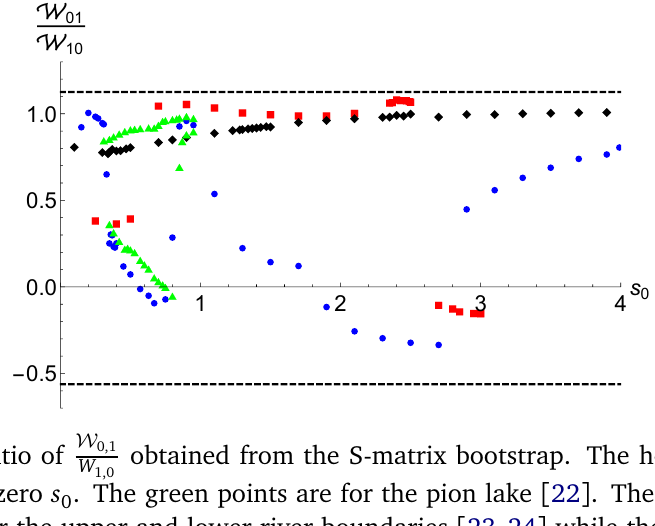
W 0,1 Figure 3: Ratio of obtained from the S-matrix bootstrap. The horizontal axis W 1,0 is the Adler zero s . The green points are for the pion lake [ 22 ] . The blue and red 0 points are for the upper and lower river boundaries [ 23, 24 ] while the black points are for the line of minimum averaged total cross section S-matrices [ 24 ]